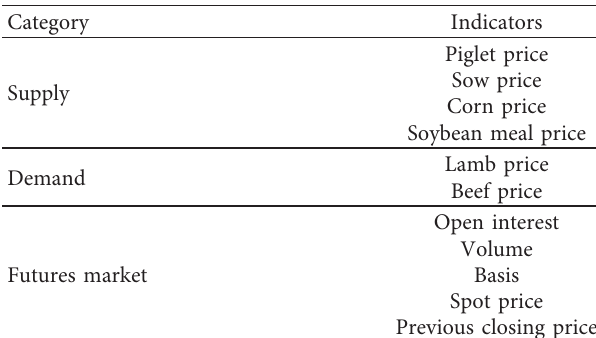
Table 1: Primary indicator system for hog futures prices.